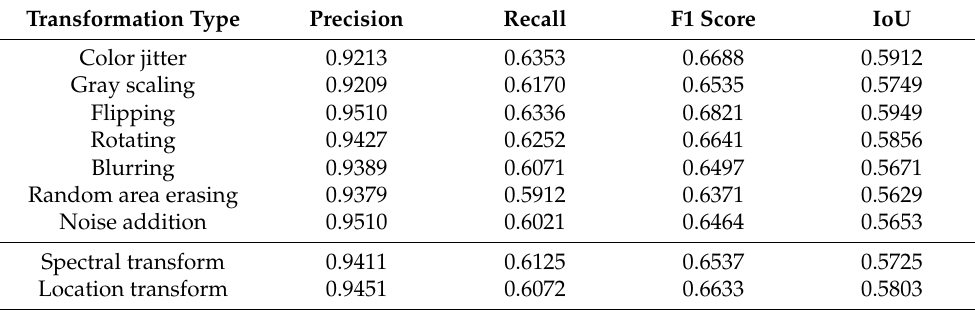
Table 3. Evolution results of different types of image transformation.